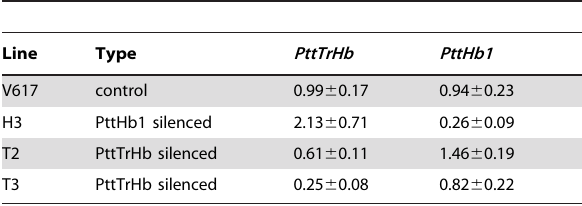
Table 1. Expression of PttTrHb and PttHb1 in control line V617 and RNAi-silenced lines, H3, T2 and